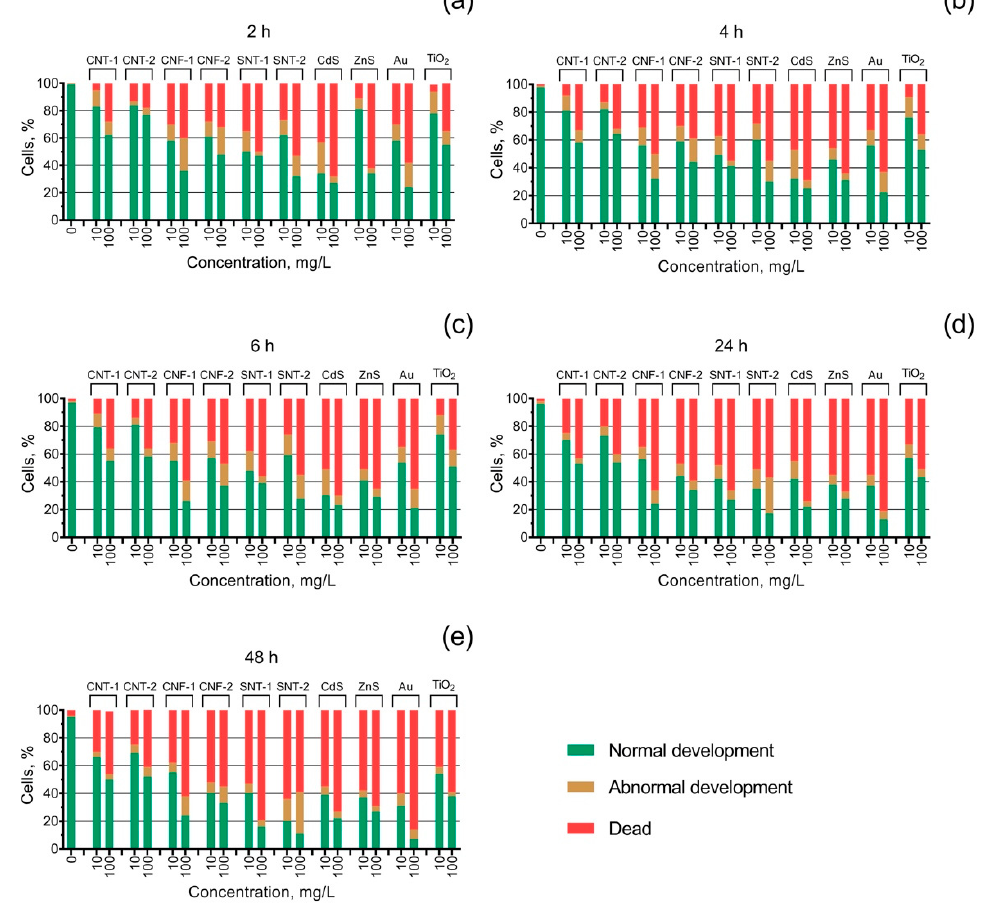
Figure 2. The state of S. intermedius embryo development under the exposure to the tested nanoparticles at the concentrations of 10 and 100 mg/L: ( a ) 2 h of the exposition; ( b ) 4 h of the exposition; ( c ) 6 h of the exposition; ( d ) 24 h of the exposition; ( e ) 48 h of the exposition.